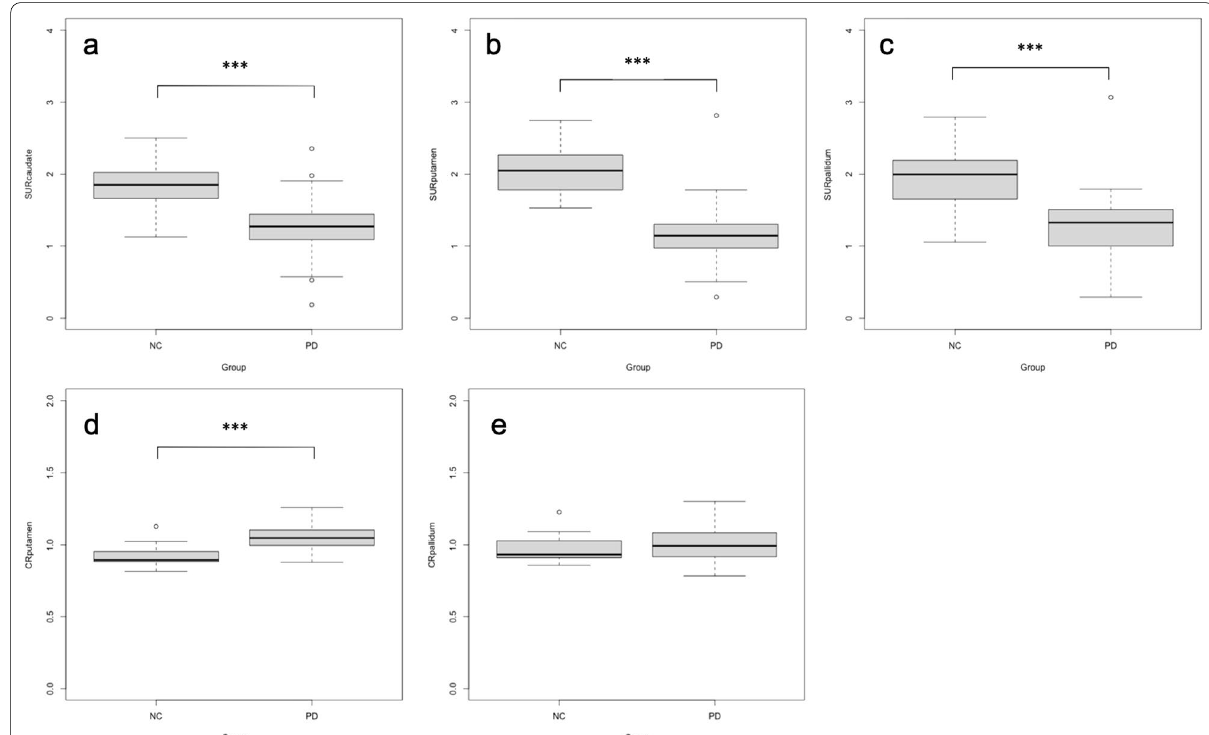
Fig. 2 Striatum uptake ratio (SUR) and caudate ratio (CR) between the normal control and Parkinson’s disease for test dataset 1. Box-and-whisker plots indicate the semi-quantitative indices distribution. a SUR caudate , b SUR putamen , c SUR pallidum ; d, CR putamen , e CR pallidum . *** P <